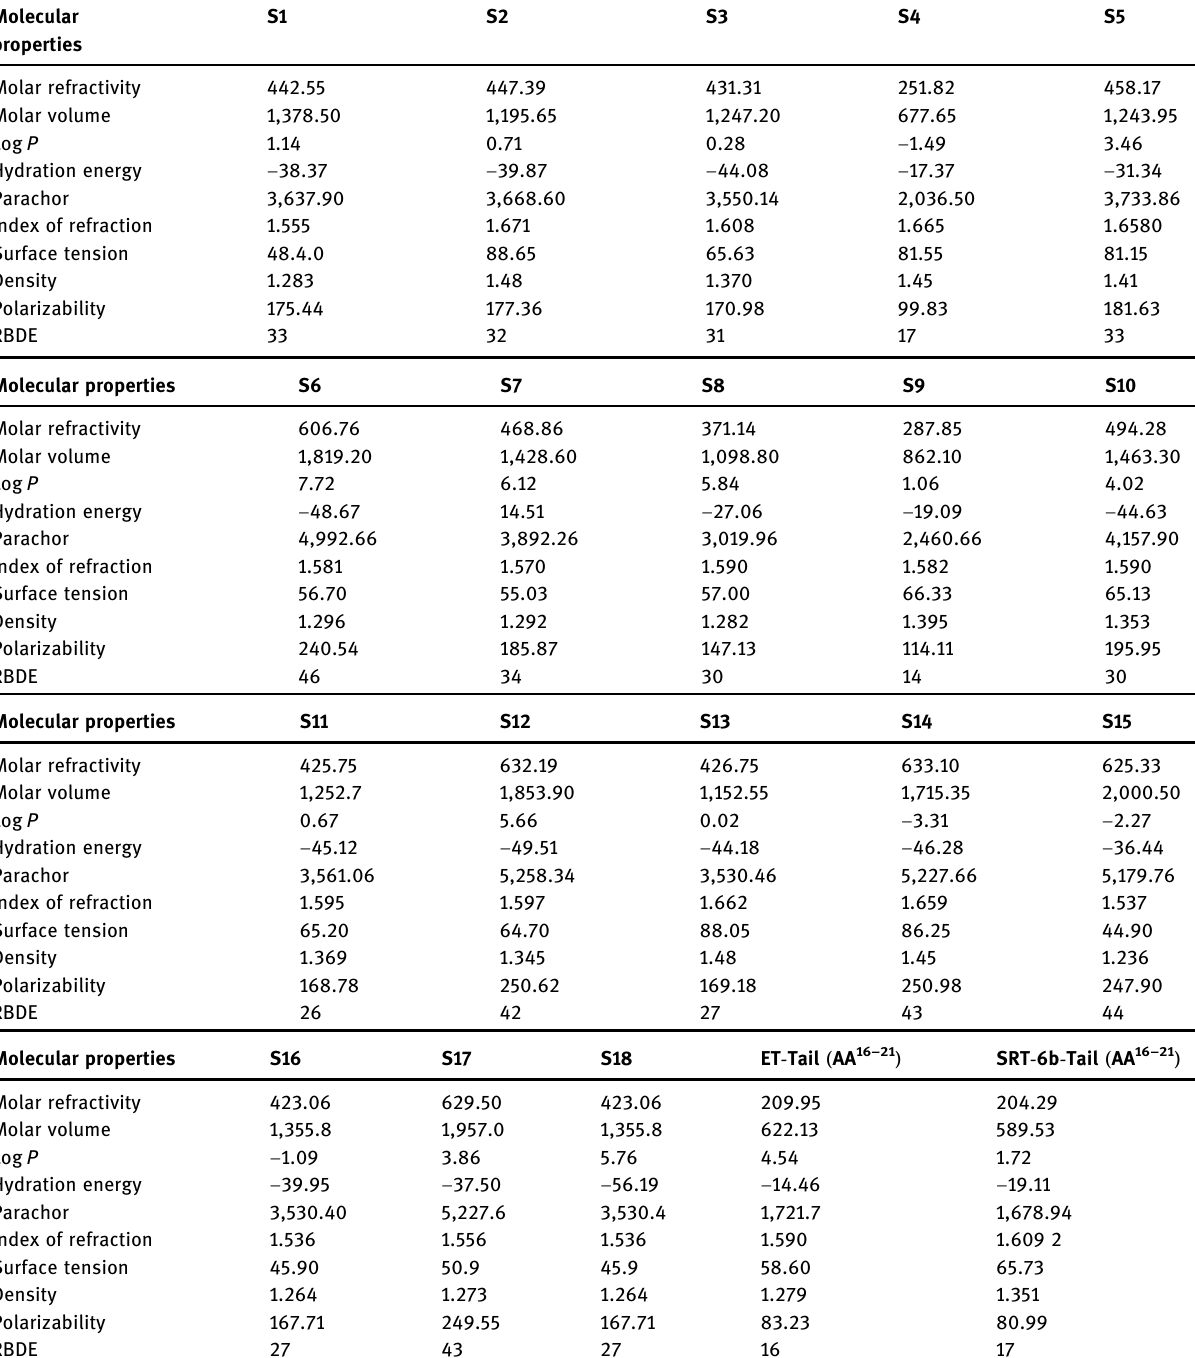
Table 2: Molecular attributes and QSAR properties of the ETs and SRT - 6b derived structures ( S1 – S18 )